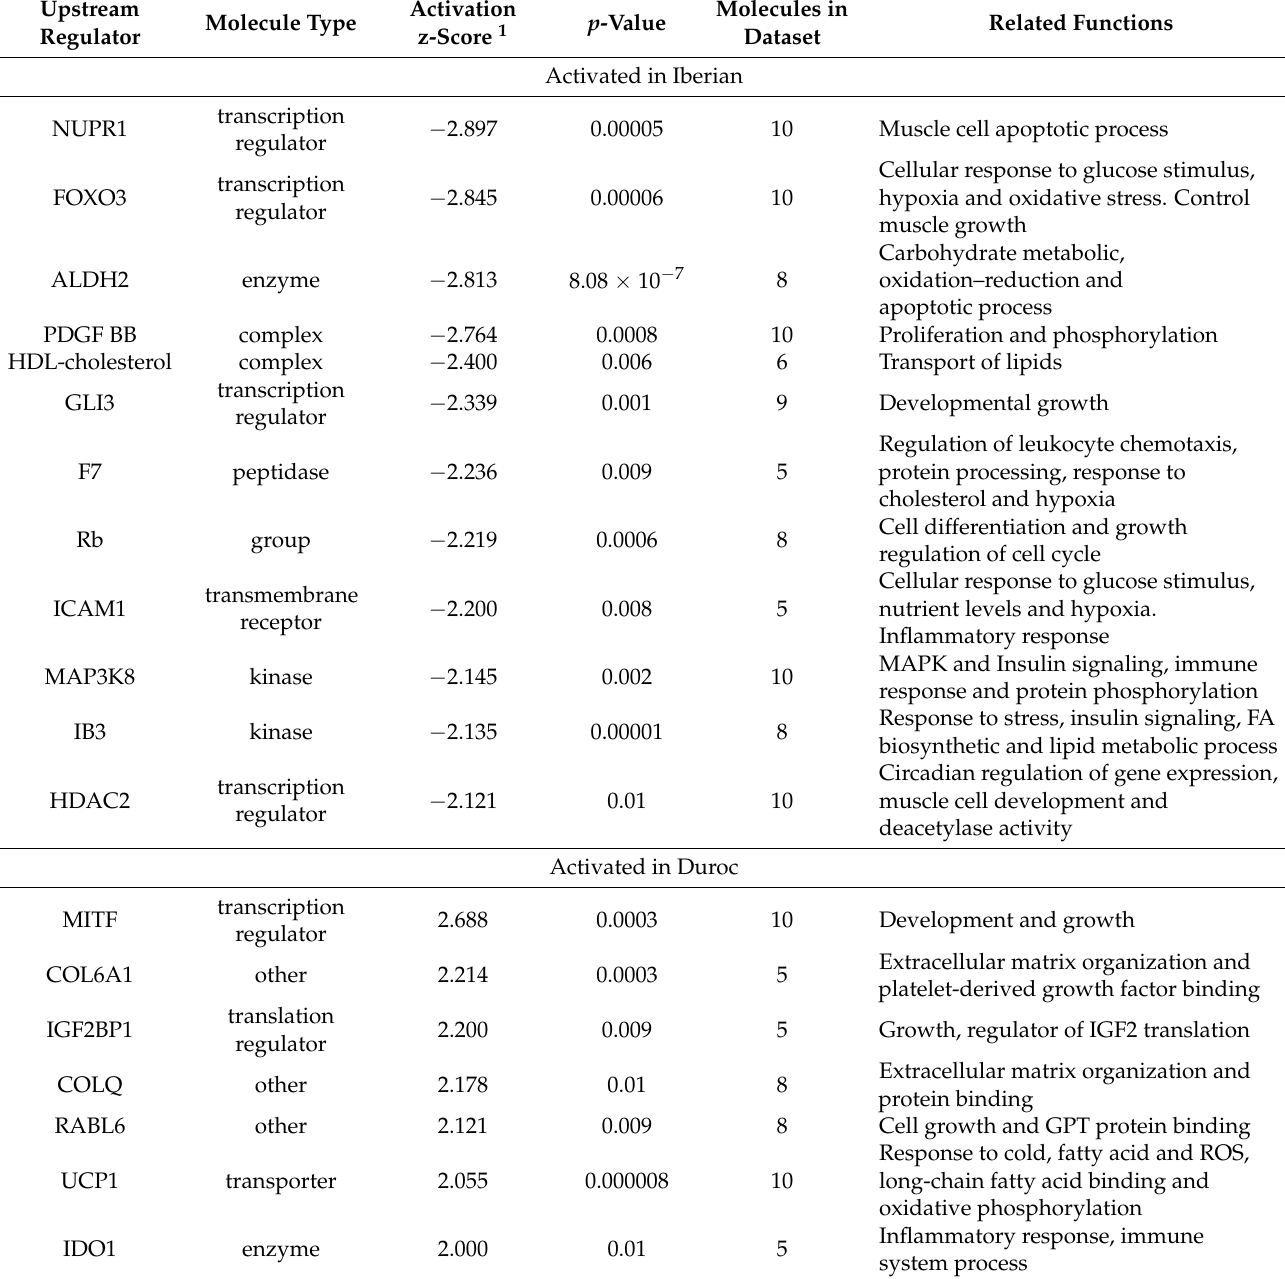
Table 6. IPA-based list of activated upstream regulators (sorted by z-score) for the set of DEGs according to breed ( p -value < 0.01 and z-score > 2 or < −